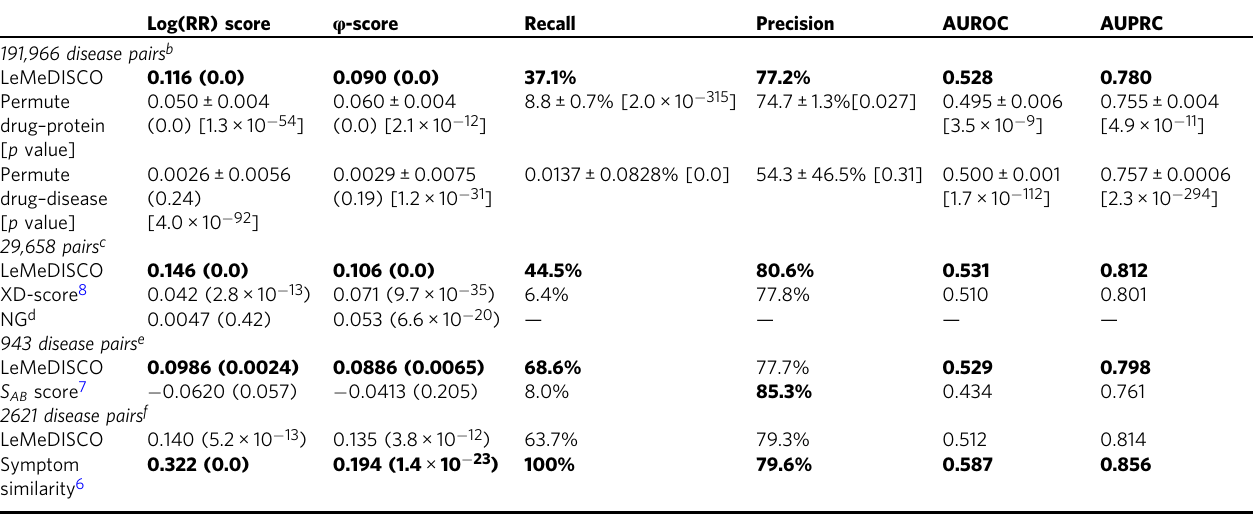
a Numbers inparentheses “ () ” are the p values of the correspondingcorrelation. Boldindicates the best resultsfor the givendataset. For the permutations of drug – protein and drug – diseaserelationships, the average±standard deviation of 100 runs with different random seeds was given, the number in parenthesis “ [] ” is the p value converted from the z -score = (LeMeDISCO value-average)/standard deviation to characterize the statistical signi fi cance of the difference between LeMeDISCO and permutation tests. b Mapping the DOID IDs from the human DO database to ICD-9 IDs of ref. 1 , gives a set of 191,966 disease pairs. c Mapped the ICD-9 disease code to our DOID of DO and obtained a consensus subset of 29,658 disease pairs from Table 1 ’ s dataset of 97,665 disease pairs in ref. 8 . d NG is the number of shared genes between disease pairs in ref. 8 . e Consensus set of 943 disease pairs from the dataset of ref. 7 and our dataset of 191,966. f A consensus dataset of 2621 disease pairs was obtained from their Supplementary dataset 4 of ref. 6 compared to our set of 191,966